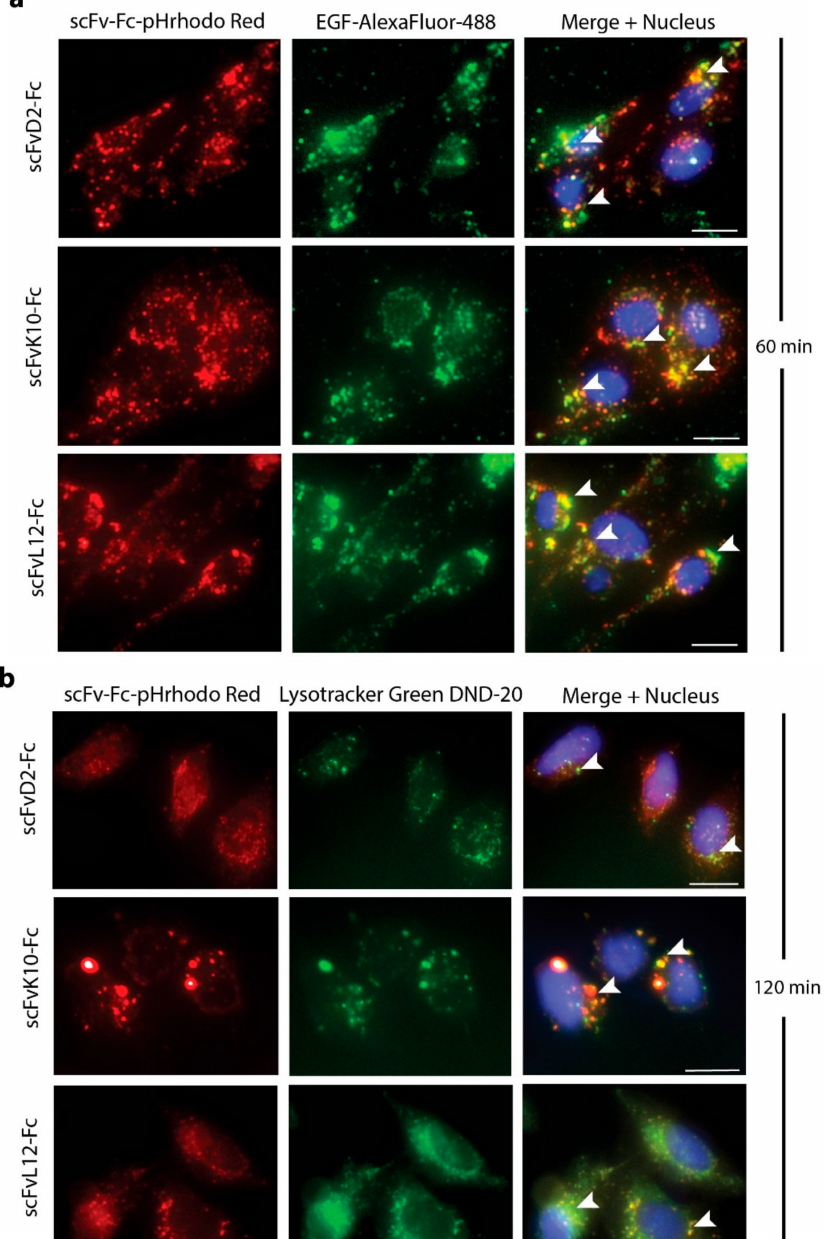
Figure 4. Intracellular trafficking of engineered antibodies. ( a ) U2OSR1 cells were incubated for 1 h with pHrodo Red labeled scFv proteins (red) and EGF-AlexaFluor-488 (green) (marker of internalization pathway directing cargo for lysosomal degradation). Nuclei were stained with NucBlue Live (blue) and cells were analyzed by fluorescence microscopy. Scale bars represent 20 µ m. ( b ) U2OSR1 cells were incubated for 2 h with pHrodo Red labeled scFv proteins (red). Lysosomes were subsequently stained with Lysotracker Green DND-20 (green) and nuclei were labeled with NucBlue Live (blue). Cells were analyzed by fluorescence microscopy. Arrowheads mark selected regions of high degree of signal colocalization. Scale bars represent 20 µ